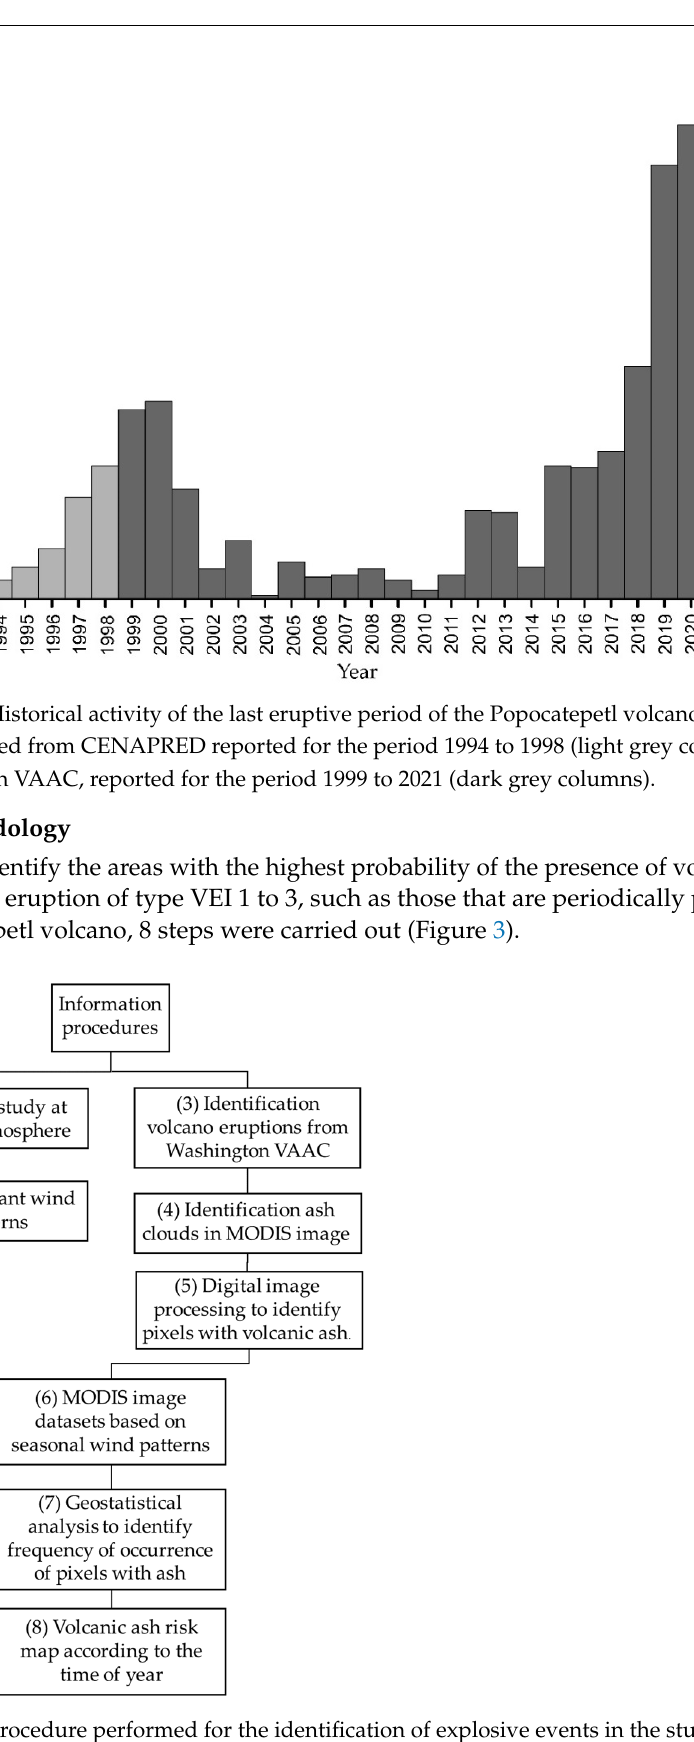
Figure 3. Procedure performed for the identification of explosive events in the study period and the digital processing of satellite images to identify areas affected most frequently by volcanic ash.